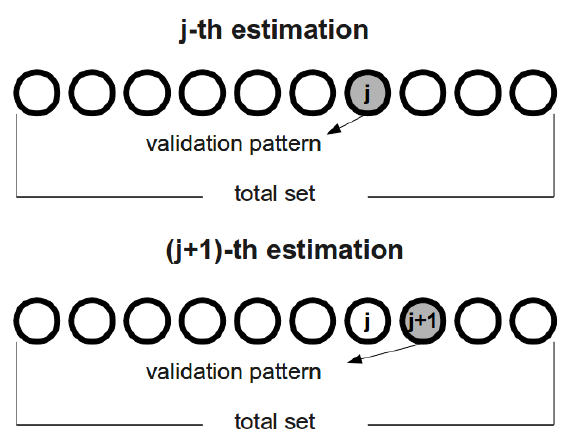
Figure 3. The cross-validation procedure used in this